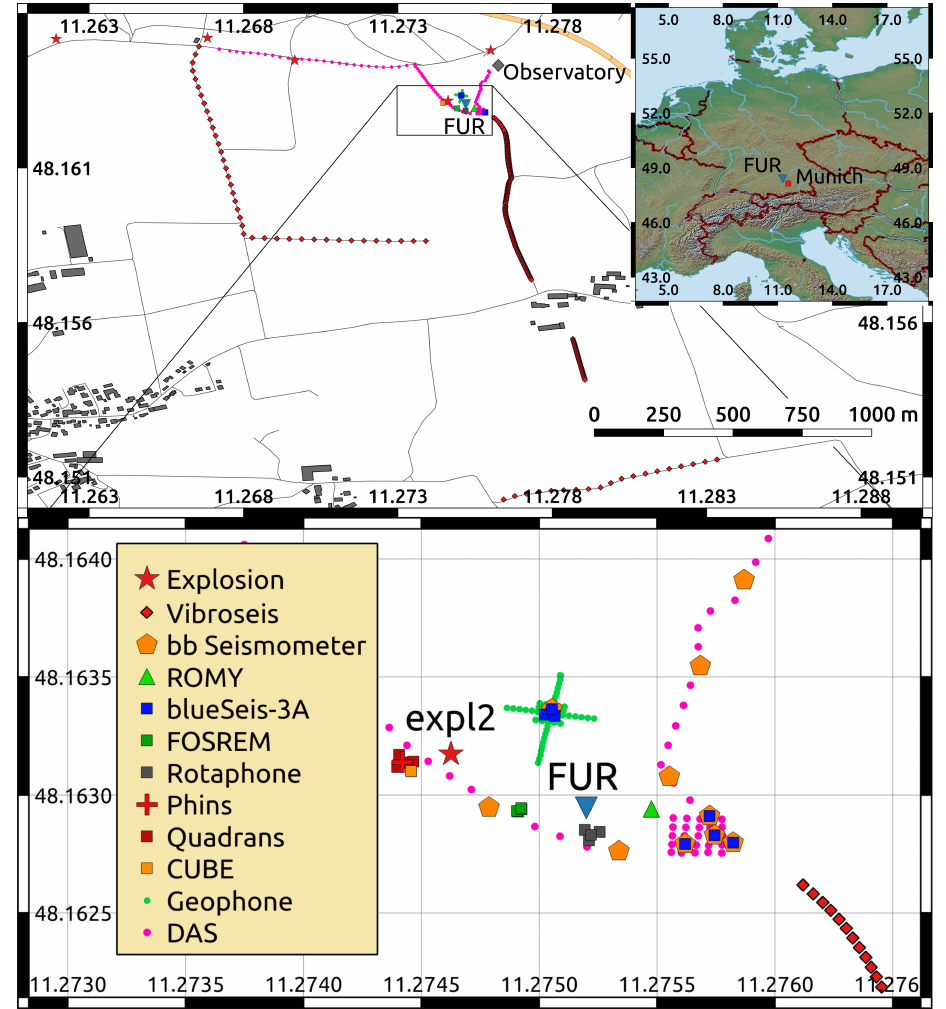
Figure 1. The Experiment was located at the Geophysical Observatory in Fürstenfeldbruck, approxi- mately 25 km to the West of Munich, Germany. Five explosions were fired within a distance range from 50m to 1.1km from the instrument installations. The Vibroseis sweeps took place within a distance range of 20m to 1.5km to the instrument installations. For the huddle test, all of the rotation sensors were installed in the seismic bunker of the German Regional Seismic Network station